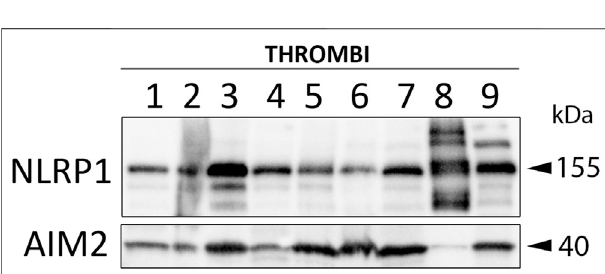
FIGURE 5 | NLRP1 and AIM2 are expressed in the clots of patients with AIS. Immunoblot analysis of clots from nine AIS patients that were blotted for NLRP1 and AIM2.